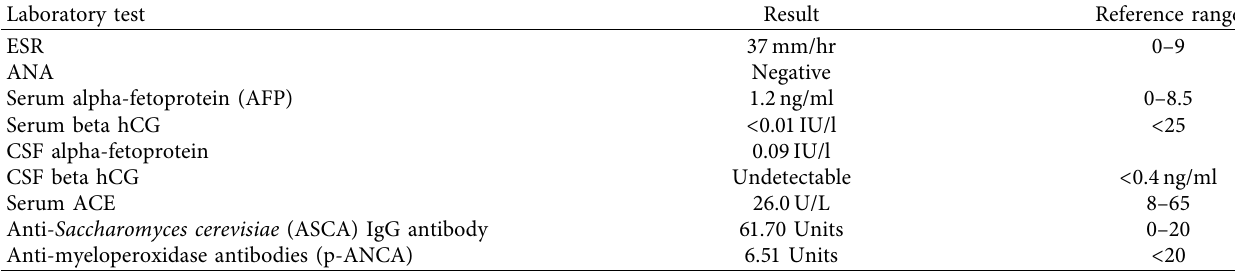
Table 1: Diagnostic evaluation for etiology of secondary hypophysitis.